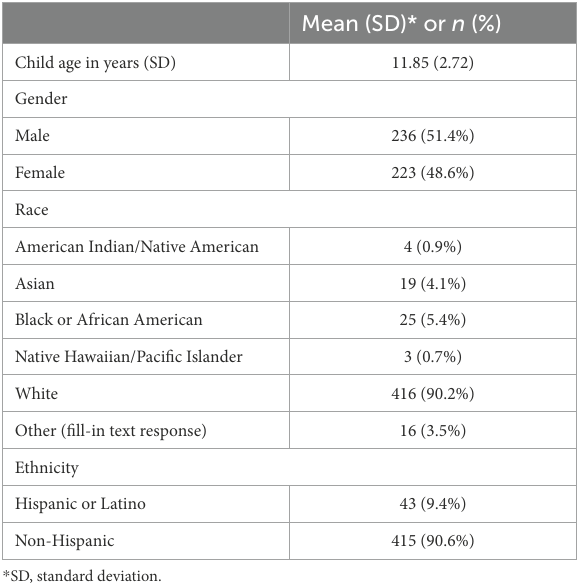
TABLE 1 Child dyad demographic characteristics ( N =